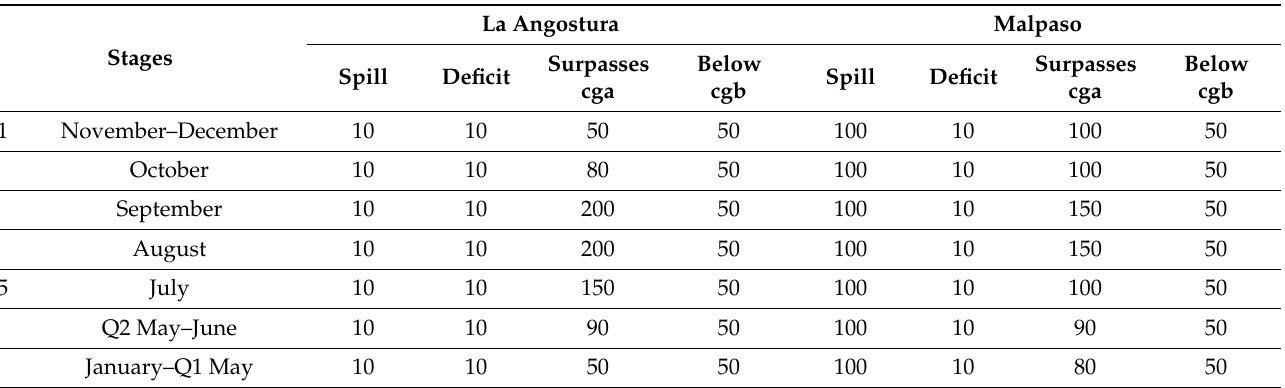
Table 2. Conditions for optimization: penalty coefficients for spill, deficit, and overrun of high (cga) and low (cgb) guide